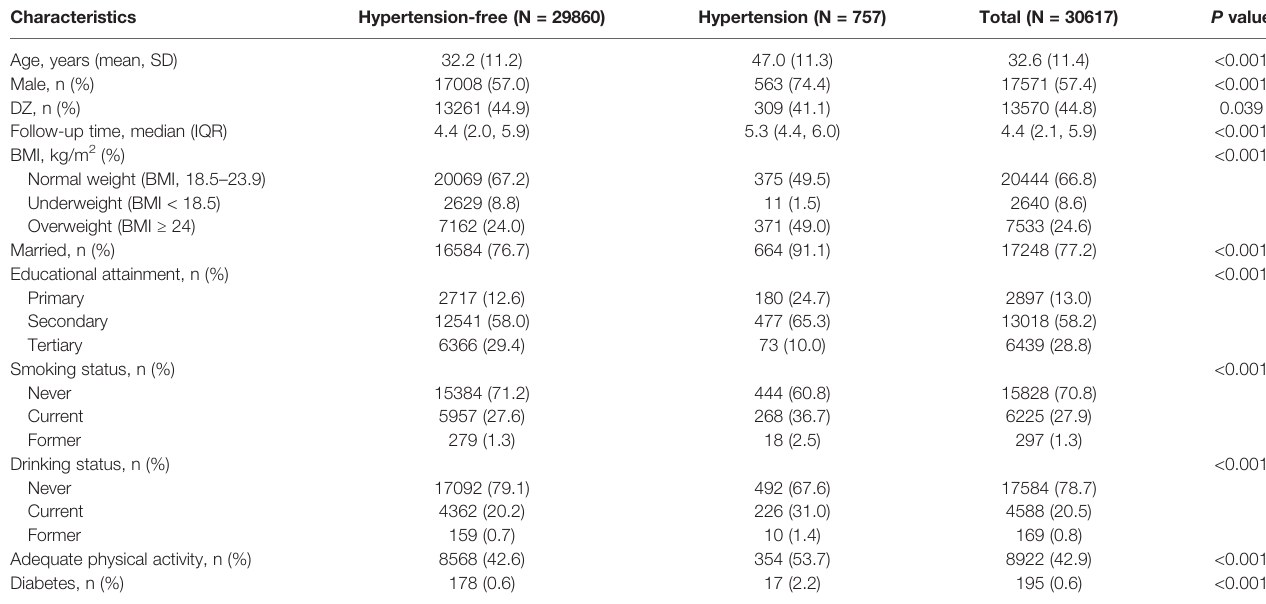
TABLE 1 | Characteristics of the study participants by hypertension diagnosis (N = 30617).